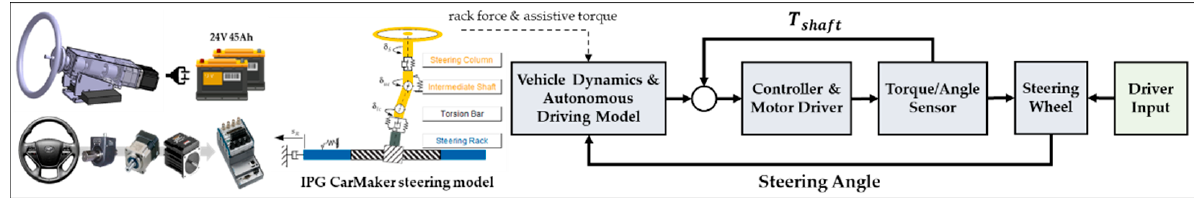
Figure 4. Steering system and control system block diagram.